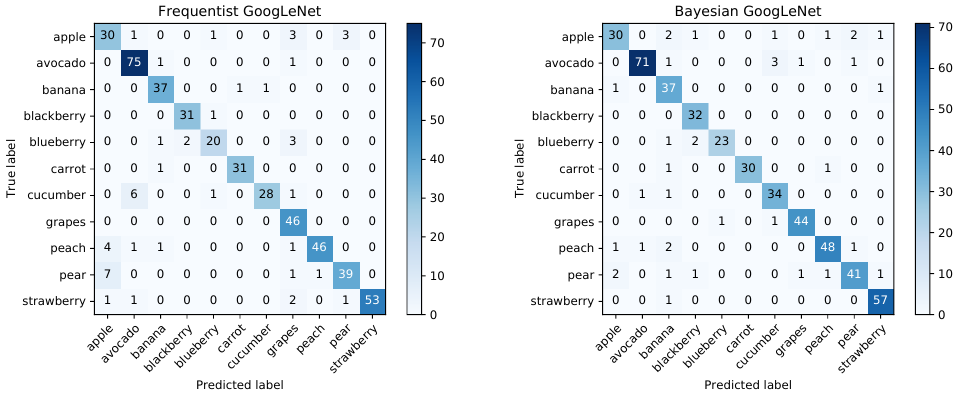
Figure 12. Confusion matrices for the frequentist and Bayesian GoogLeNet.